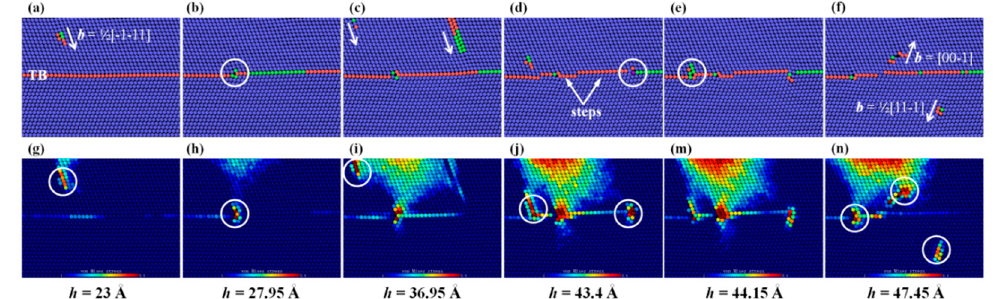
Figure 4. Sliced atomic configurations related to dislocationcoherent twin boundary (CTB) interaction, in ( a – f ) atoms are colored by PTM, corresponding distributions of Mises stress are shown in ( g – n ). In Figures ( a )–( f ) the dislocations activities are indicated by white circles, and the corresponding stress concentration in Figures ( g )–( n ) is also indicated by white circles.